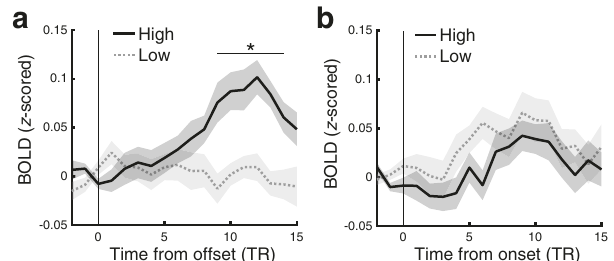
Fig. 6 Effects of semantic centrality on hippocampal event boundary responses. Mean hippocampal blood oxygenation level-dependent (BOLD) response time courses aligned at the offset ( a ) or onset ( b ) of events during movie watching. Solid lines and dotted lines show responses for the high and low semantic centrality events, respectively. The BOLD time course of each event was fi rst baseline corrected by subtracting the mean response of the two TRs (TR = 1.5 s) immediately preceding the offset/ onset of the event from each time point. The baseline-corrected time courses were averaged across events within each movie and then across movies and participants. Shaded areas indicate SEM across participants. Statistical signi fi cance re fl ects the difference between High vs. Low centrality events at each time point. * q < .05 (FDR corrected across time points). Source data are provided as a Source Data fi